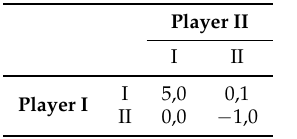
Table 1. Equilibria in a bi-matrix game.